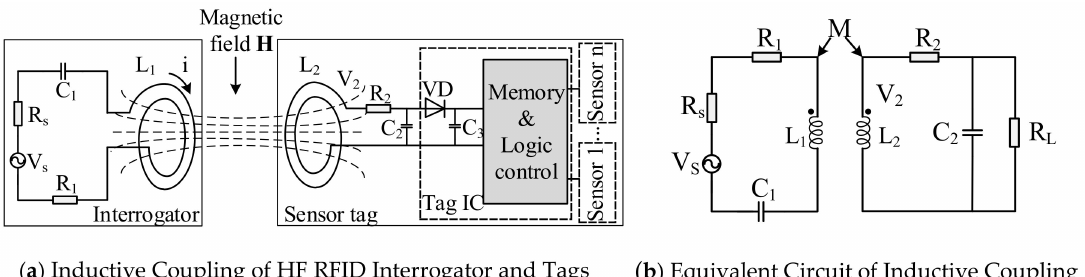
Figure 1. The Fundamentals of HF RFID